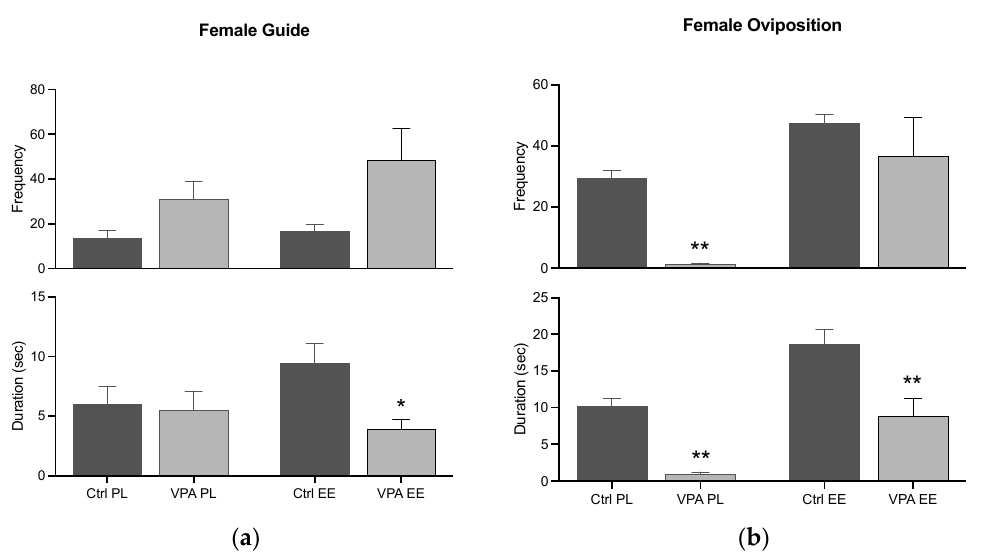
Figure 6. Male preconsummatory behaviors. The graph shows how many times the male touched ( a ) and encircled ( b ) the female (frequency) and how long he displayed such behaviors for (duration). Data show the mean ± SEM. * = p < 0.05; ** = p < 0.01.